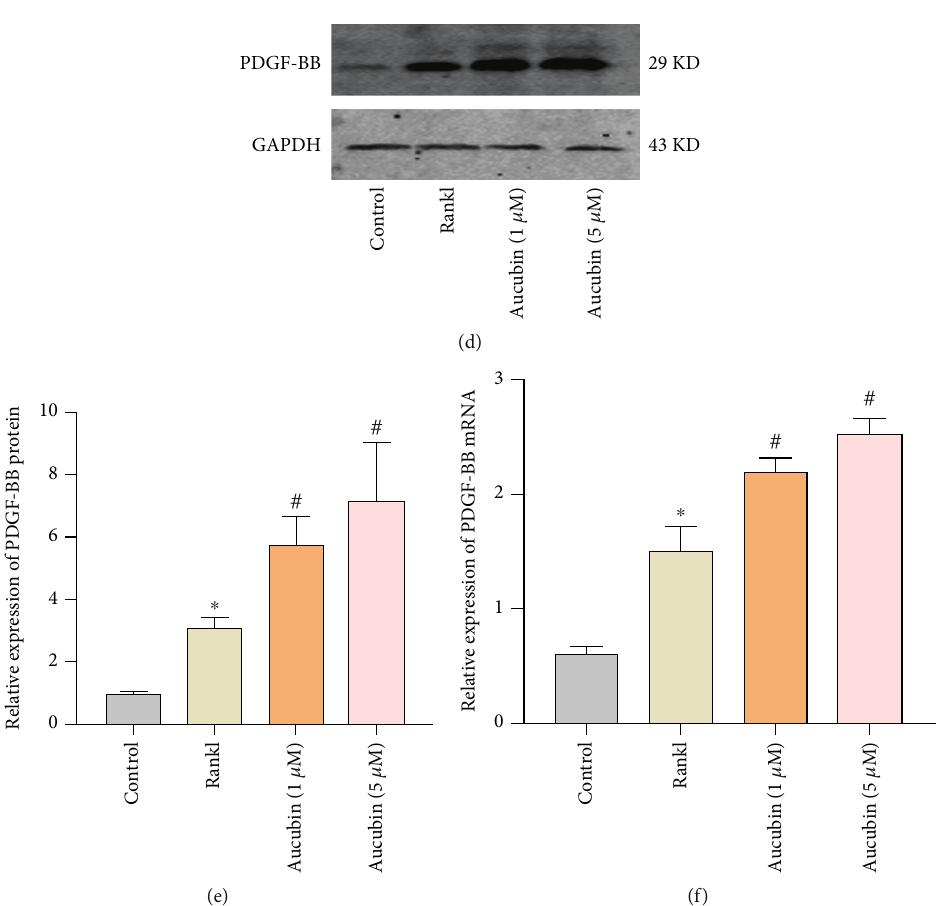
Figure 4: Aucubin augments the production of PDGF-BB in vitro. (a) IF staining was performed to observe the production of PDGF-BB. Scale bar: 50 μ m. (b) Quanti fi cation of the relative PDGF-BB fl uorescence intensity. (c) Concentration of PDGF-BB in CM was analyzed by ELISA. (d) Protein levels of PDGF-BB were analyzed by WBs. (e) Quanti fi cation of PDGF-BB protein expression with di ff erent treatments. (f) Quanti fi cation of PDGF-BB mRNA expression with di ff erent treatments. ∗ P < 0 : 05 compared to the control group; # P < 0 : 05 compared to the Rankl